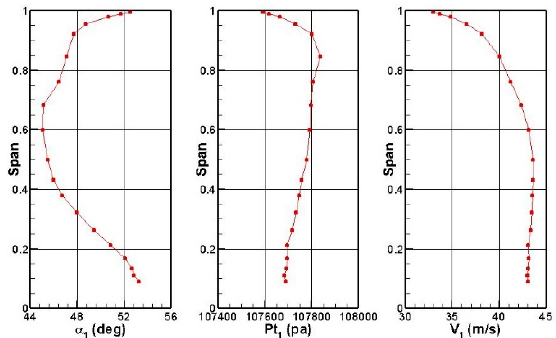
Figure 5. The radial distribution of total temperature, flow angle, and velocity at inlet.